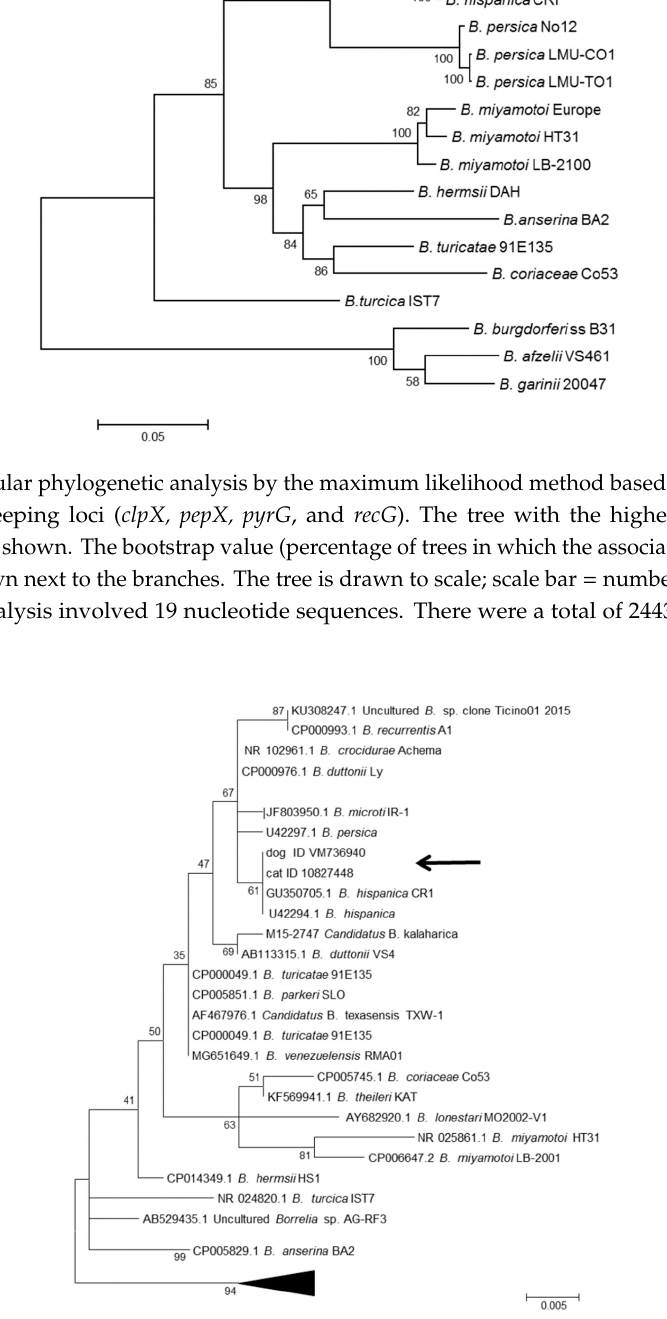
Figure 3. Molecular phylogenetic analysis by maximum likelihood method 16S rRNA. The tree with the highest log likelihood ( − 1091.6698) is shown. The bootstrap value (percentage of trees in which the associated taxa are clustered together) is shown next to the branches. The tree is drawn to scale; scale bar = number of substitutions per site. The analysis involved 43 nucleotide sequences, and the GenBank accession number, species names, and isolate names are given. There were a total of 418 positions in the final dataset. The subtree containing 17 B. burgdorferi sensu lato genospecies is collapsed for clarity.